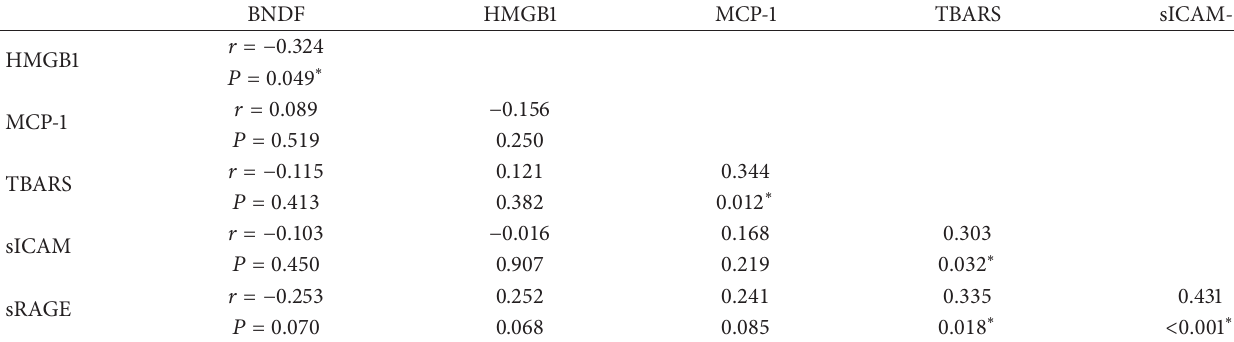
Table 2: Pearson correlation coefficients between serum levels of the studied factors.